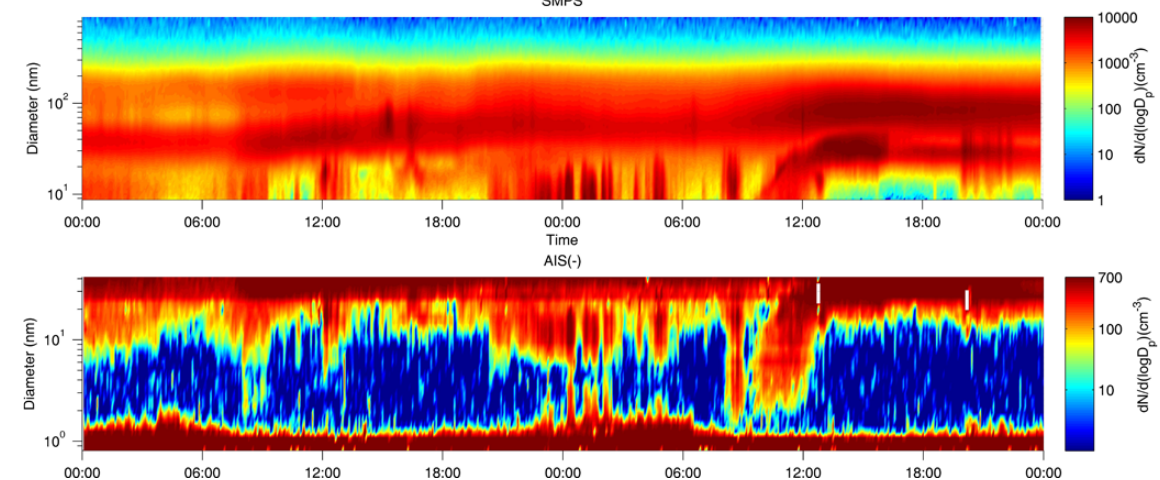
Fig. 5. Aerosol particles size distribution in the size range 8–900nm (upper panel) and atmospheric ions size distribution in the size range 0.8–42nm (lower panel) for the period 6–7 October 2008. New particle formation observed on 7 October as recorded by SMPS and AIS for negative polarity. The night before, new ions were formed and grew sufficiently to be recorded by the SMPS. Time of the day in